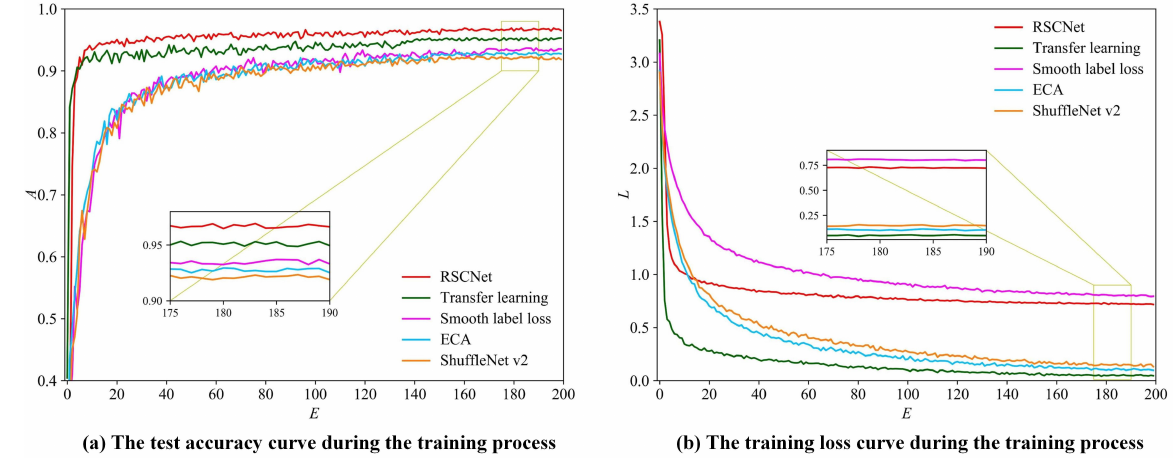
Figure 8. Training curve of ablation experiment. A is the top1 accuracy, L is the loss value, and E is epoch. The training rate is 0.8.